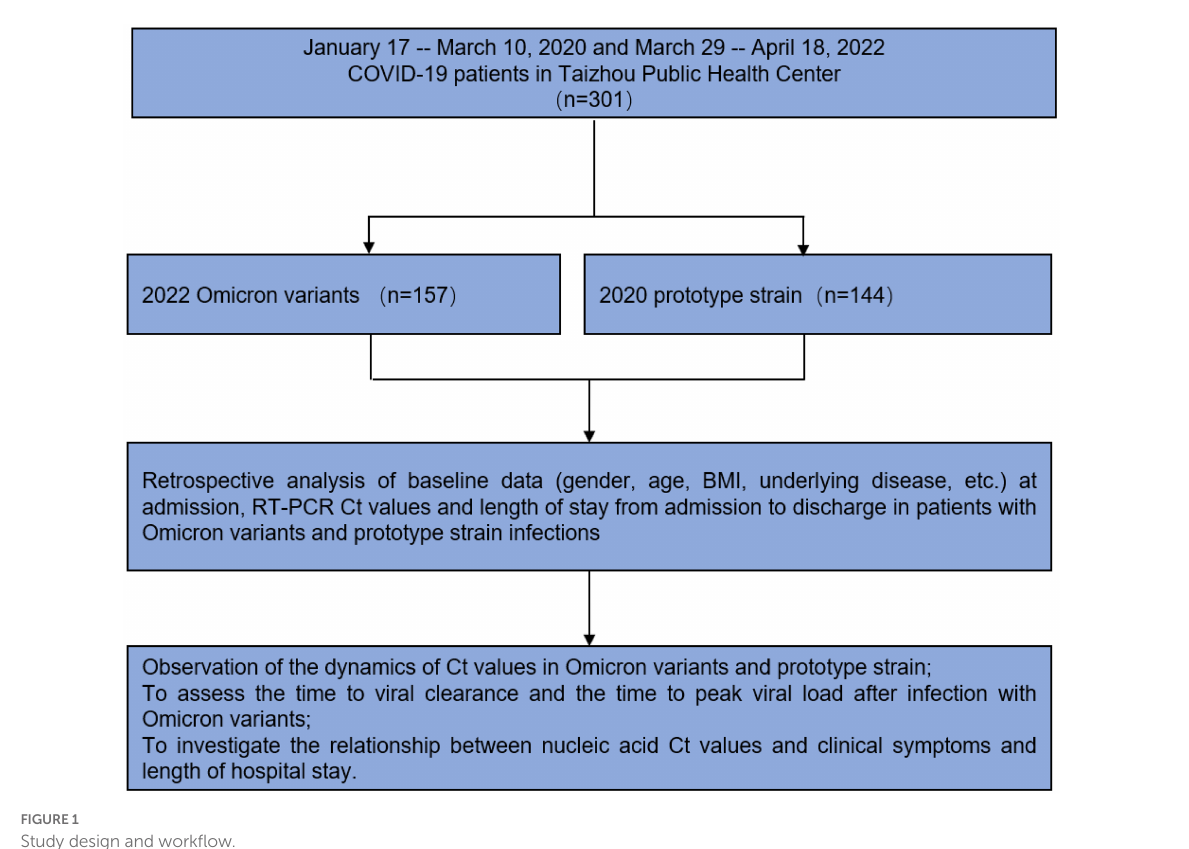
FIGURE 1 Study design and